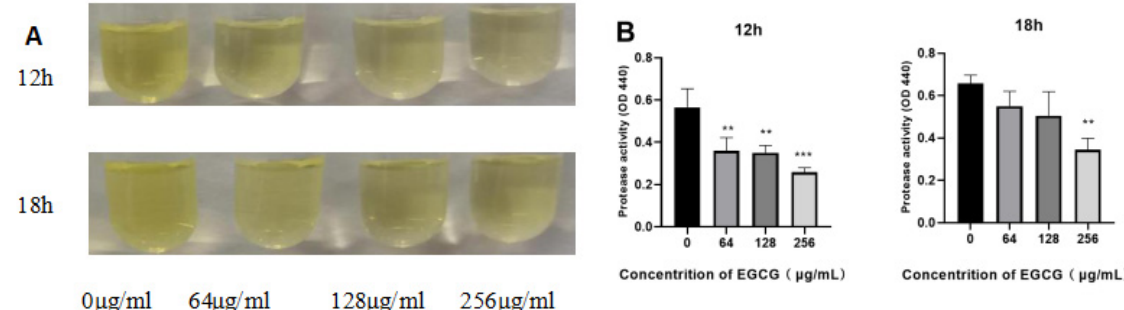
Figure 5. The inhibition of EGCG on protease activity in P. aeruginosa . ( A ) Images of the azocasein and virulent supernatant reaction product. ( B ) The quantitative estimated value of protease activity. (All data are representative of three independent experiments performed in triplicate and expressed as the mean ± SD values in each bar. ** p < 0.01; *** p < 0.001).